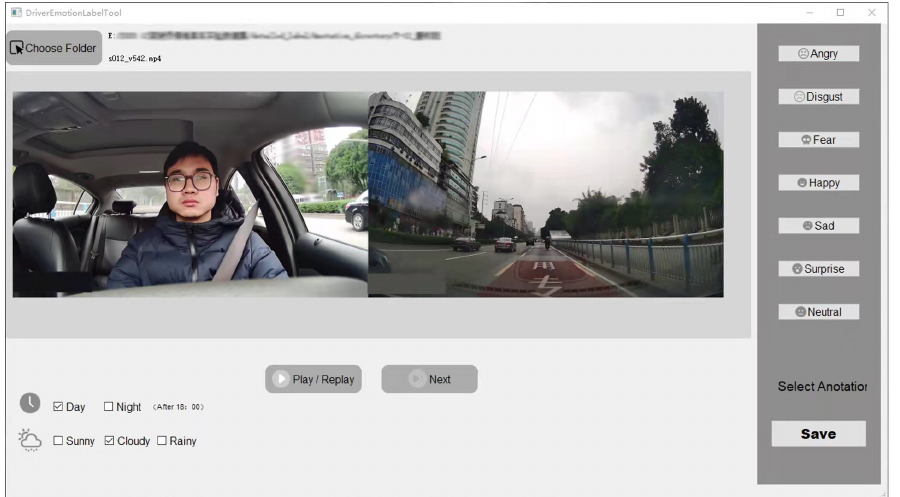
Figure 3. Screenshot of the developed annotation tool called “DriverEmotionLabelTool”, used to annotate the video sequences of the on-road driver facial expression dataset.